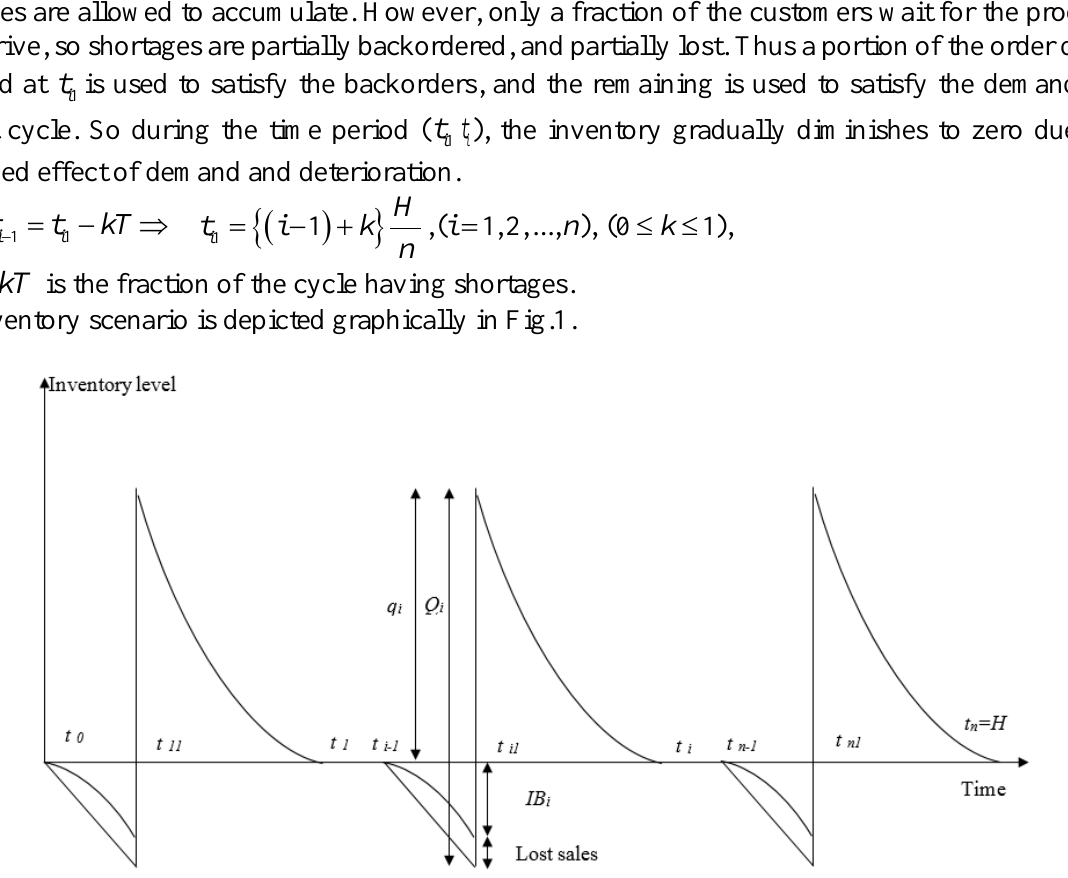
Fig. 1. Pictorial Representation of Inventory